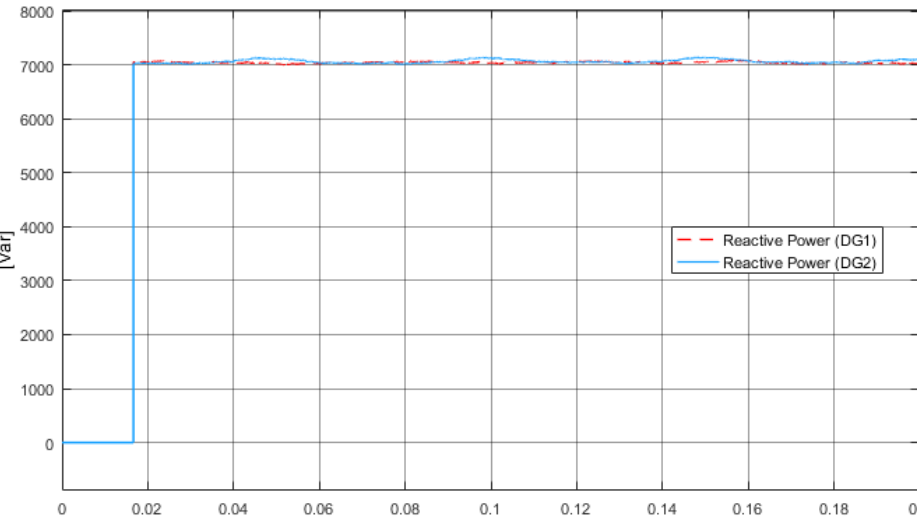
Figure 13. The waveform of the active power of DGs for parallel operation in GC mode.